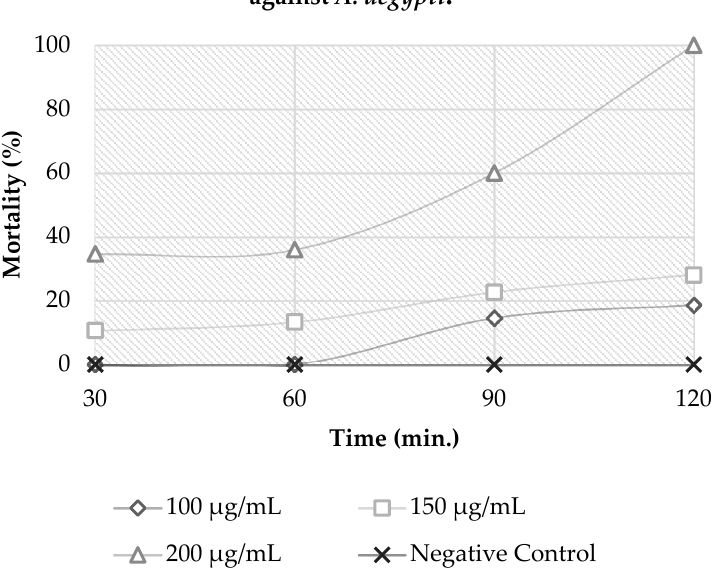
Figure 2. Adulticidal activity of P. heptaphyllum nanoemulsion against A. aegypti .